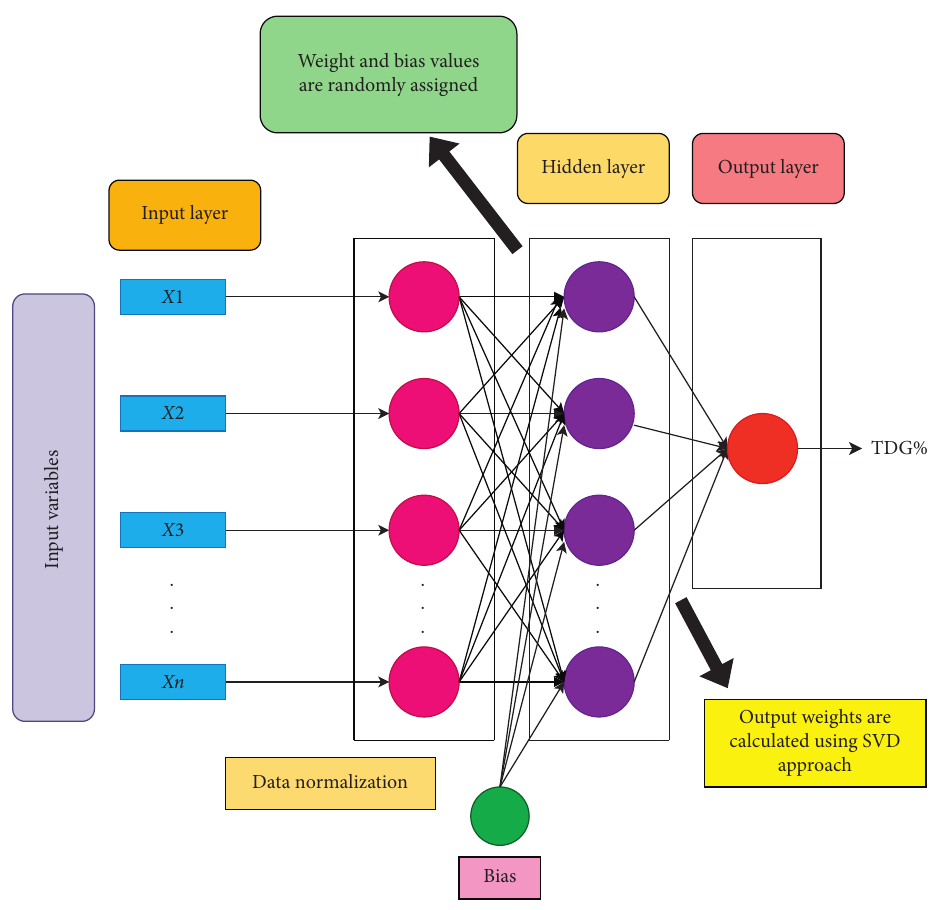
Figure 2: Extreme learning machine (ELM)